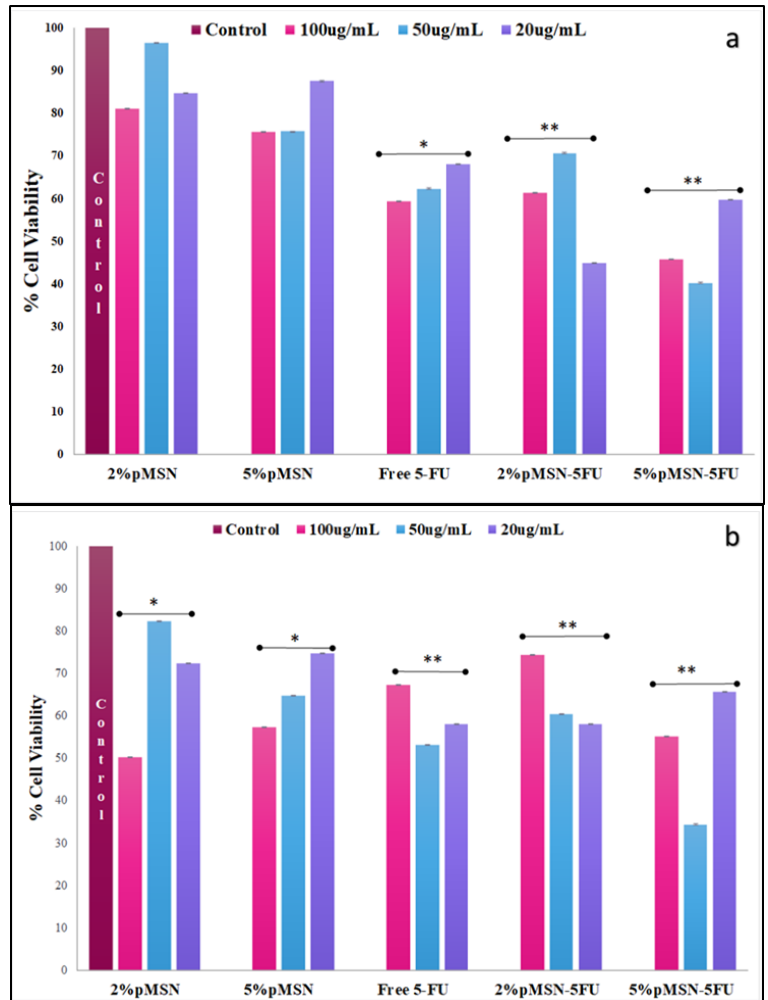
Figure 7. ( a ) MTT and ( b ) SRB assay of f-MSNs and 5-FU-loaded MSNs administered at various concentrations (20, 50, and 100 μg/ mL) in MCF-7 cells. Data is represented as mean ± SD ( n = 3). * p < 0.05 and ** p < 0.01 were considered statistically significant.